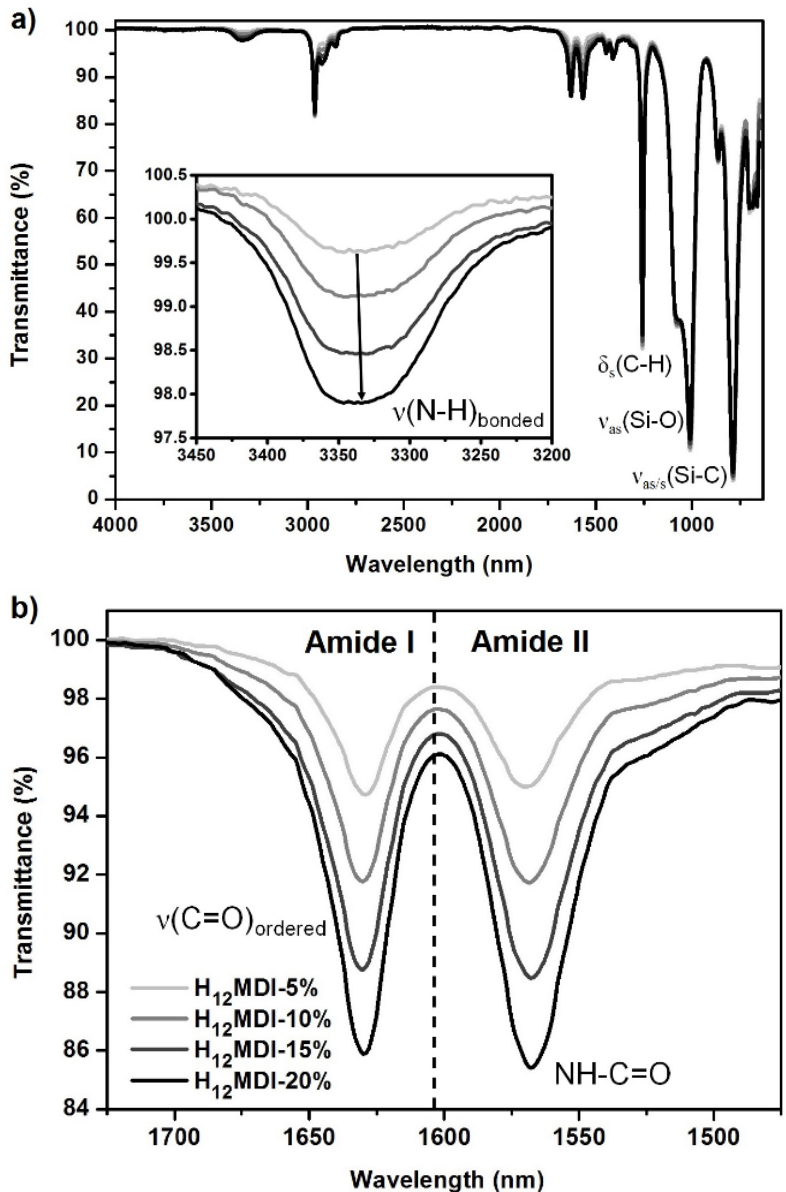
Figure A4. ATR-FTIR spectra of PDMS-based polyurea elastomers synthesized from H 12 MDI with increasing HS contents (5–20%). ( a ) The enlarged N-H stretching region at 3450–3200 cm − 1 shows that all urea groups were involved in hydrogen bonding interactions. The bands below 1500 cm − 1 correspond to the PDMS soft segment vibrations at: 1258 cm − 1 ( δ s C-H in CH 3 ), 1010 cm − 1 ( ν as Si-O), 864 cm − 1 ( δ as C-H in Si-(CH 3 ) 2 ), and 786 cm − 1 /702 cm − 1 ( ν as/s Si-C in Si-(CH 3 ) 2 ). ( b ) Enlarged region of the Amide I (C=O stretching vibration) at 1630 cm − 1 and Amide II ( ν C-N + δ N-H) vibrations at 1568 cm − 1 . The band positions of the C=O stretching vibrations indicate that all urea groups within the elastomers were hydrogen-bonded in an ordered manner [45,67,68].